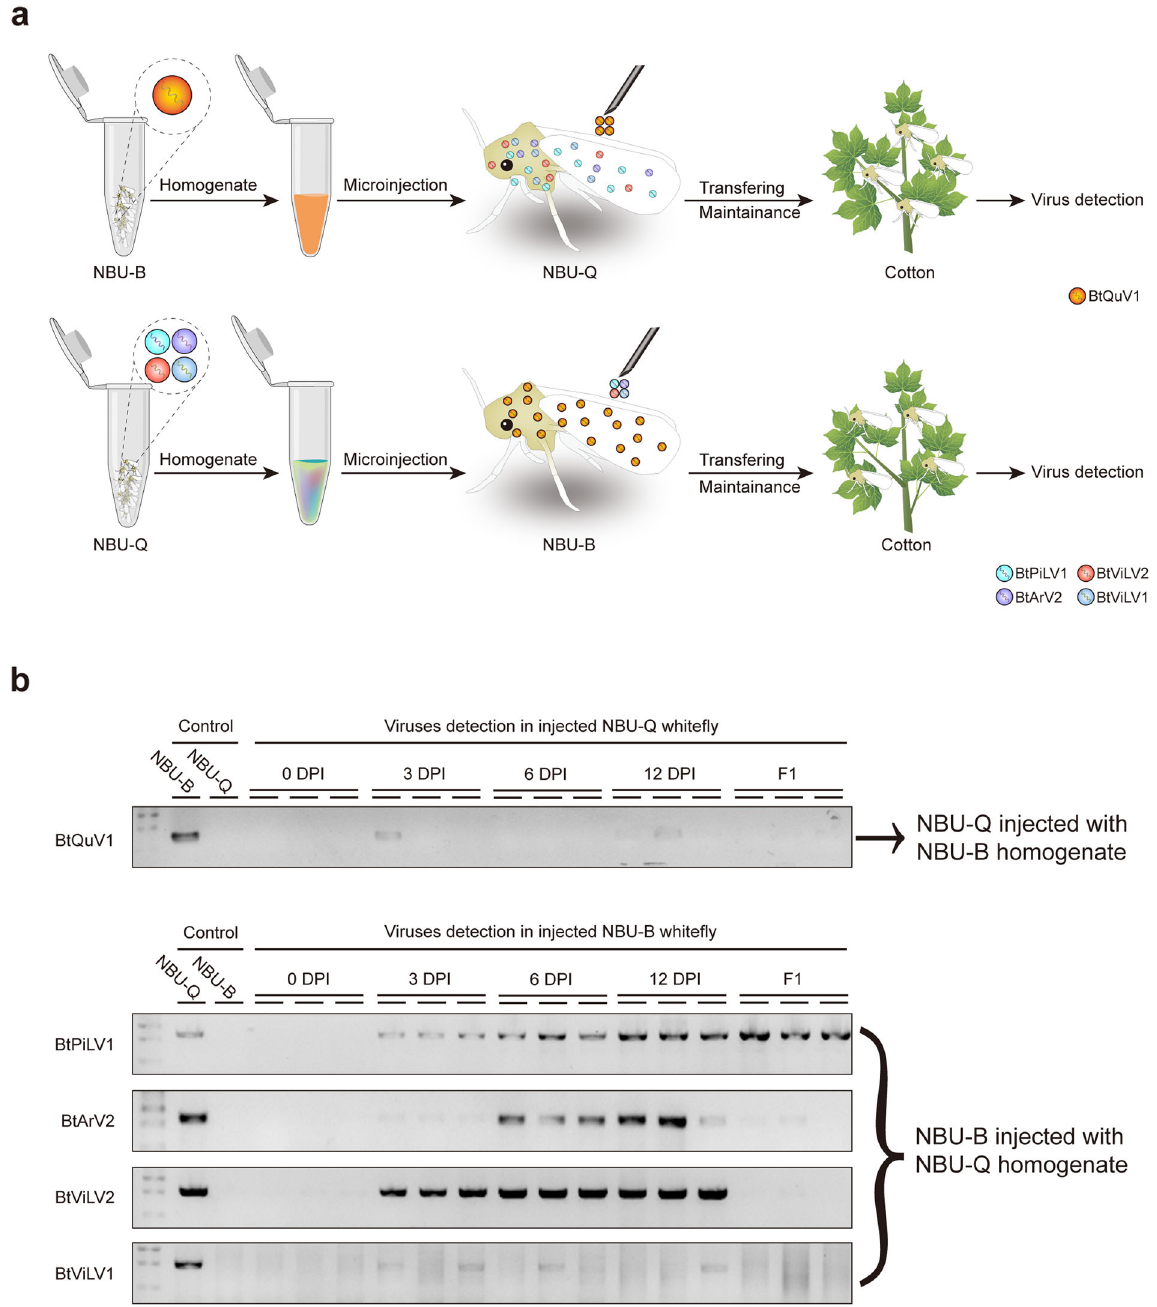
Fig. 4 Evaluation of the ability of insect-speci fi c viruses to cross-infect the cryptic white fl y species Middle East Asia Minor 1 (MEAM1) and Mediterranean (MED). a Diagram illustrating the experimental work fl ow. In the upper panel white fl y individuals of NBU-Q (representing cryptic species MED) were microinjected with homogenate of NBU-B (representing cryptic species MEAM1). The reciprocal injection of NBU-B with homogenate of NBU-Q white fl ies is shown in the lower panel. b Detection of insect-speci fi c viruses (ISVs) 0, 3, 6, and 12 days post injection (DPI), and in the next generation (F1). The presence of ISVs in each white fl y sample was determined by RT-PCR. Untreated NBU-B and NBU-Q white fl ies were used as controls. A pool of 20 – 30 white fl ies were collected for MEAM1 and MED white fl ies at each time point, and three independent biological replicates were performed. Abbreviation of virus names: BtArV2 , Bemisia tabaci arlivirus 2, BtPiLV1 Bemisia tabaci picorna-like virus 1, BtQuV1 Bemisia tabaci quaranjavirus 1, BtViLV1 Bemisia tabaci virga-like virus 1, BtViLV2 Bemisia tabaci virga-like virus